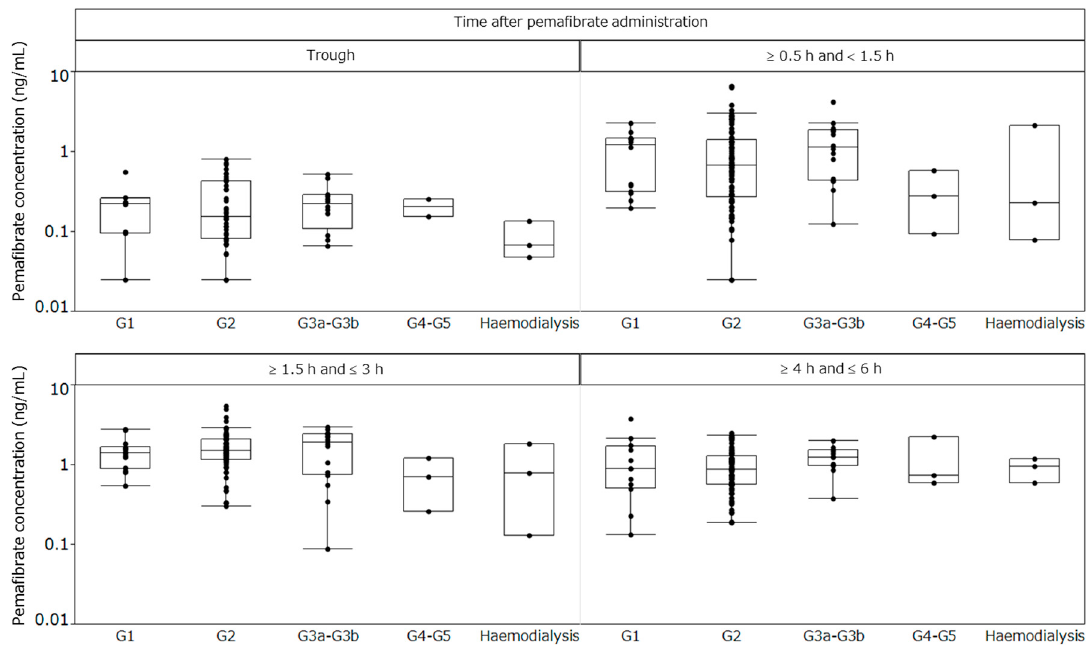
Figure 6. Plasma concentrations of pemafibrate after repeated-dose administration. Baseline eGFR categories are as follows: G1, eGFR ≥ 90 mL/min/1.73 m 2 ; G2, eGFR ≥ 60 and <90 mL/min/1.73 m 2 ; G3a–G3b, eGFR ≥ 30 and <60 mL/min/1.73 m 2 ; G4–G5, eGFR < 30 mL/min/1.73 m 2 . eGFR, estimated glomerular filtration rate.